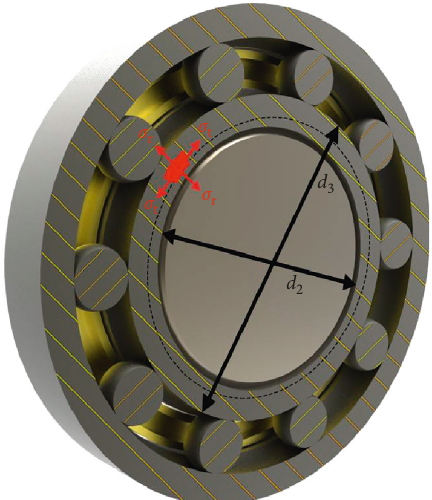
Figure 1: Radial and tangential stress occurring in the press fit bearing-shaft